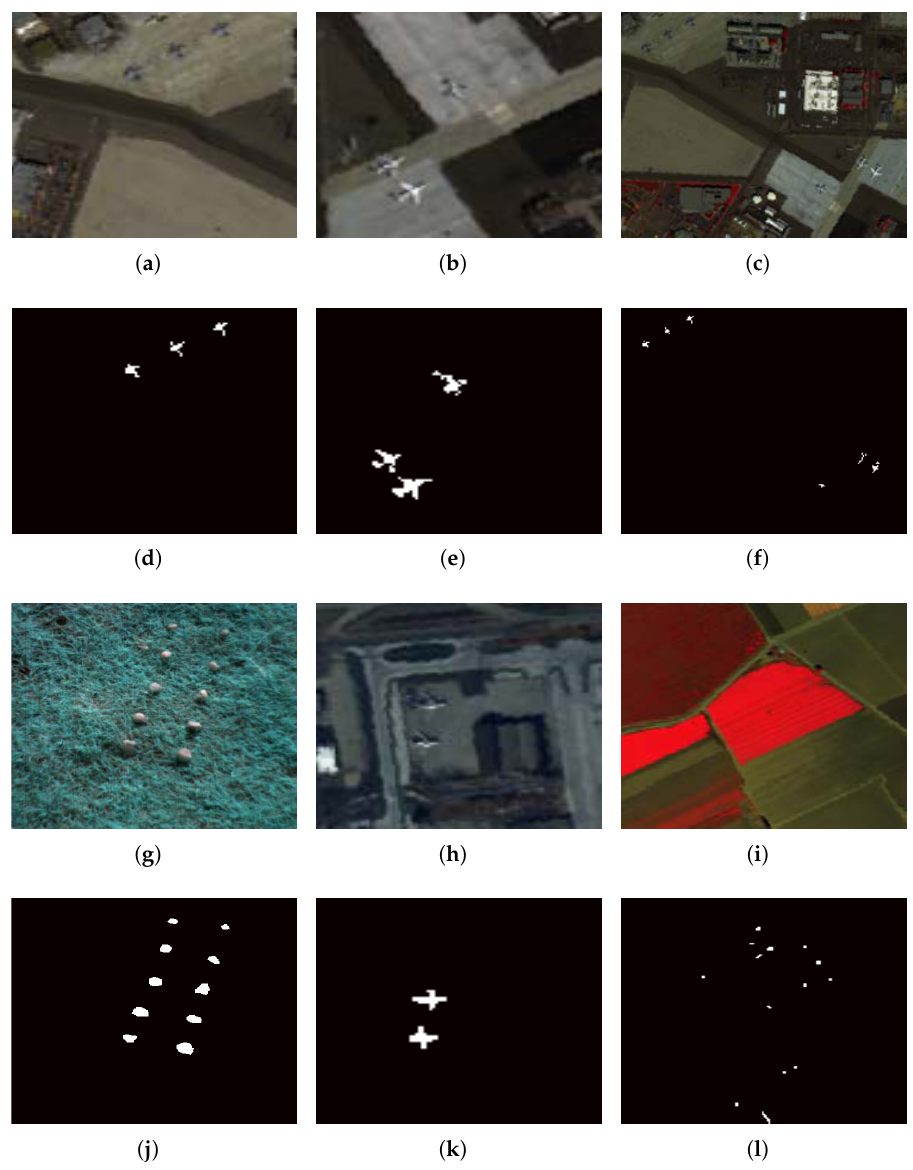
Figure 4. False color image of ( a ) Airborne Visible/Infrared Imaging Spectrometer (AVIRIS)-I, ( b ) AVIRIS-II, ( c ) AVIRIS-III. The ground truth map of ( d )AVIRIS-I, ( e ) AVIRIS-II, ( f ) AVIRIS-III. False color image of ( g ) Cri, ( h ) ABU-airport-2, ( i ) Salinas. The ground truth map of ( j ) Cri, ( k ) ABU-airport- 2, ( l )